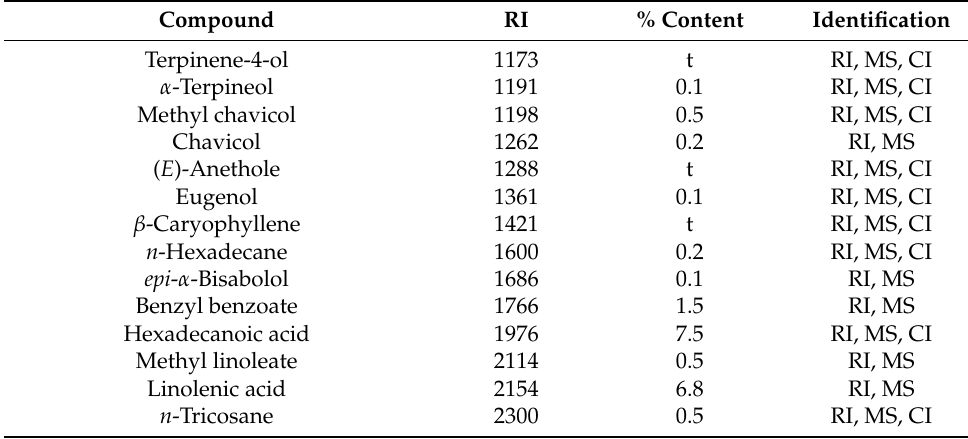
Table 1. Chemical composition of Ocimum basilicum stem